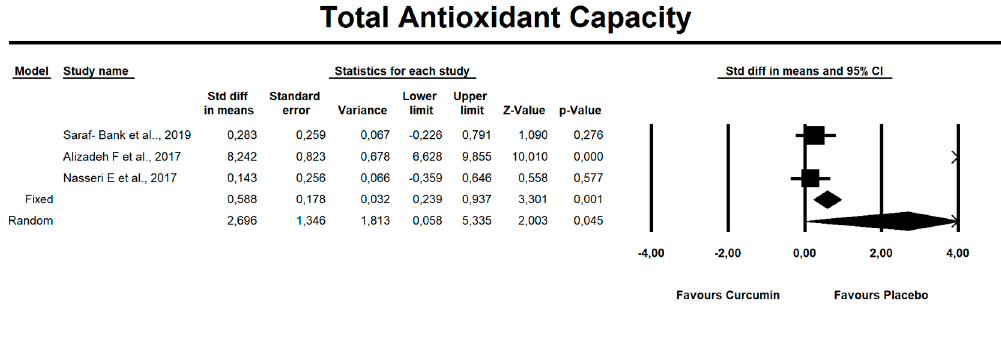
Figure 3. An effect size standardized mean difference, for TAC at endpoint in persons taking curcumin vs. controls (endpoint data). Q = 90.804, df(Q) = 2, p = 0.000, I-squared = 97.797.